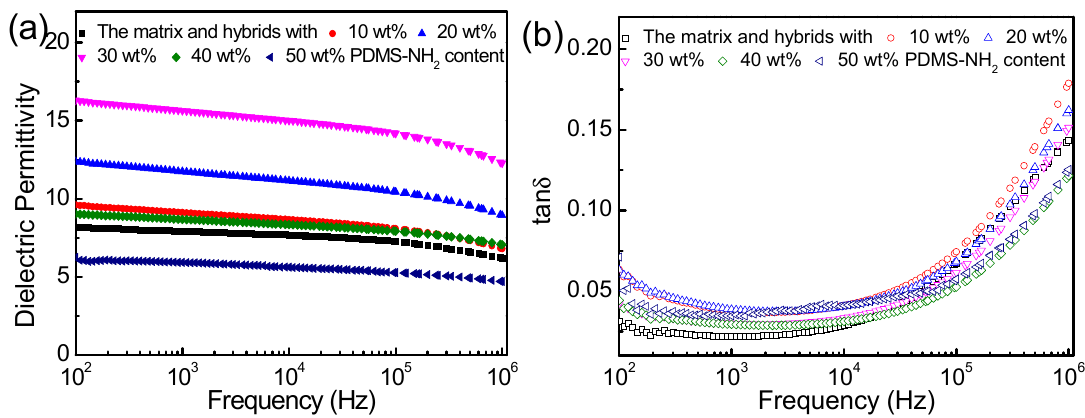
Figure 5. Frequency dependence of ( a ) the dielectric permittivity and ( b ) the loss tangent of the neat matrix and the hybrids with the indicated PDMS-NH 2 contents under room temperature.